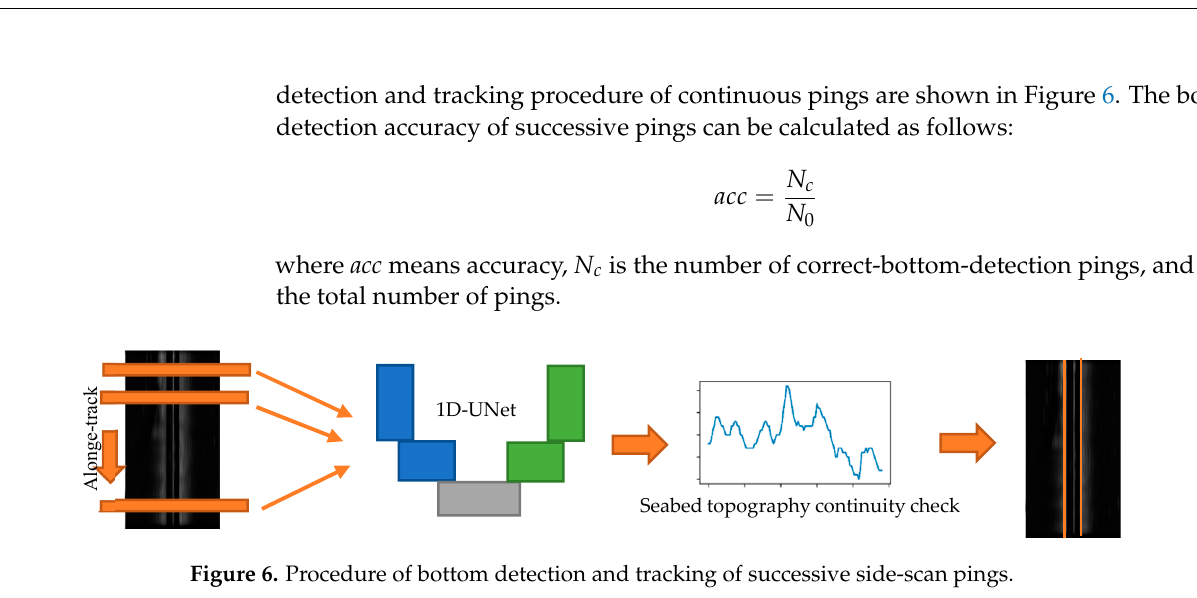
Figure 6. Procedure of bottom detection and tracking of successive side-scan pings.